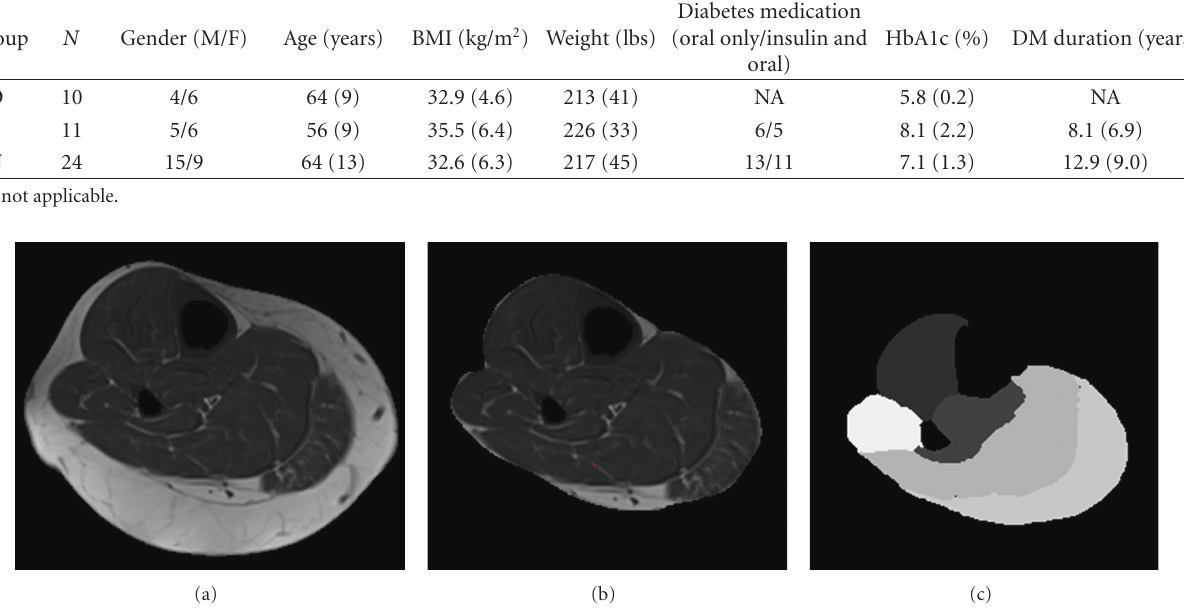
Figure 1: (a) MRI image of calf with bone removed. (b) Subcutaneous adipose tissue removed. (c) Calf divided into 5 compartments (anterior, lateral, deep, gastrocnemius, and